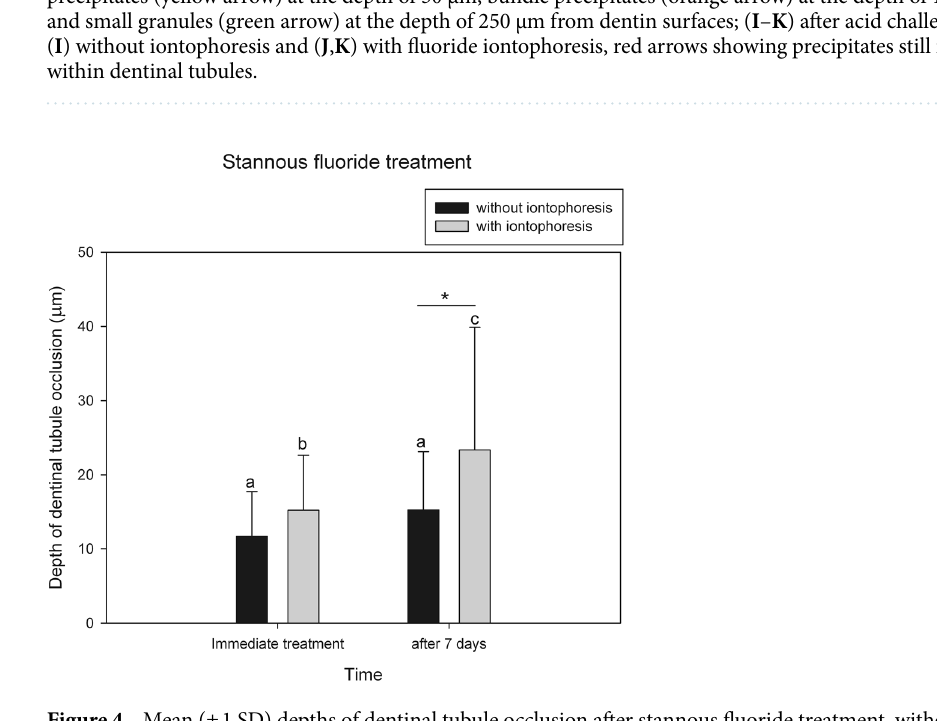
Figure 4. Mean (± 1 SD) depths of dentinal tubule occlusion after stannous fluoride treatment, without (black column) and with (gray column) iontophoresis at immediate treatment and 7 days. The same lowercase letter represents no significant change after 7 days. *Statistically significant difference between groups ( p < 0.05, 2-way ANOVA and Tukey